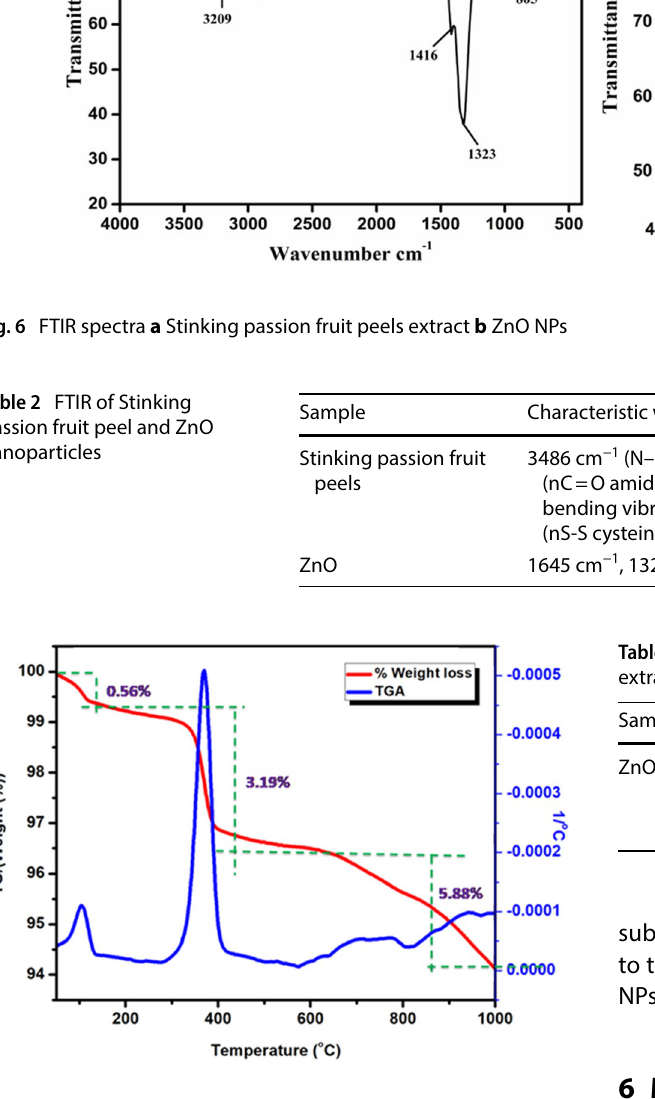
Fig. 7 Thermogravimetric analysis of ZnO